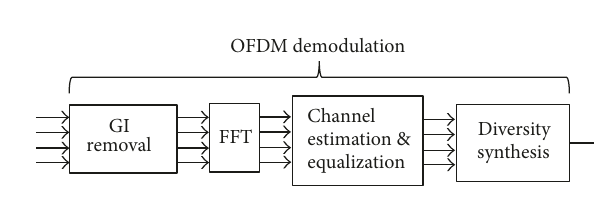
Figure 16: OFDM frame format.